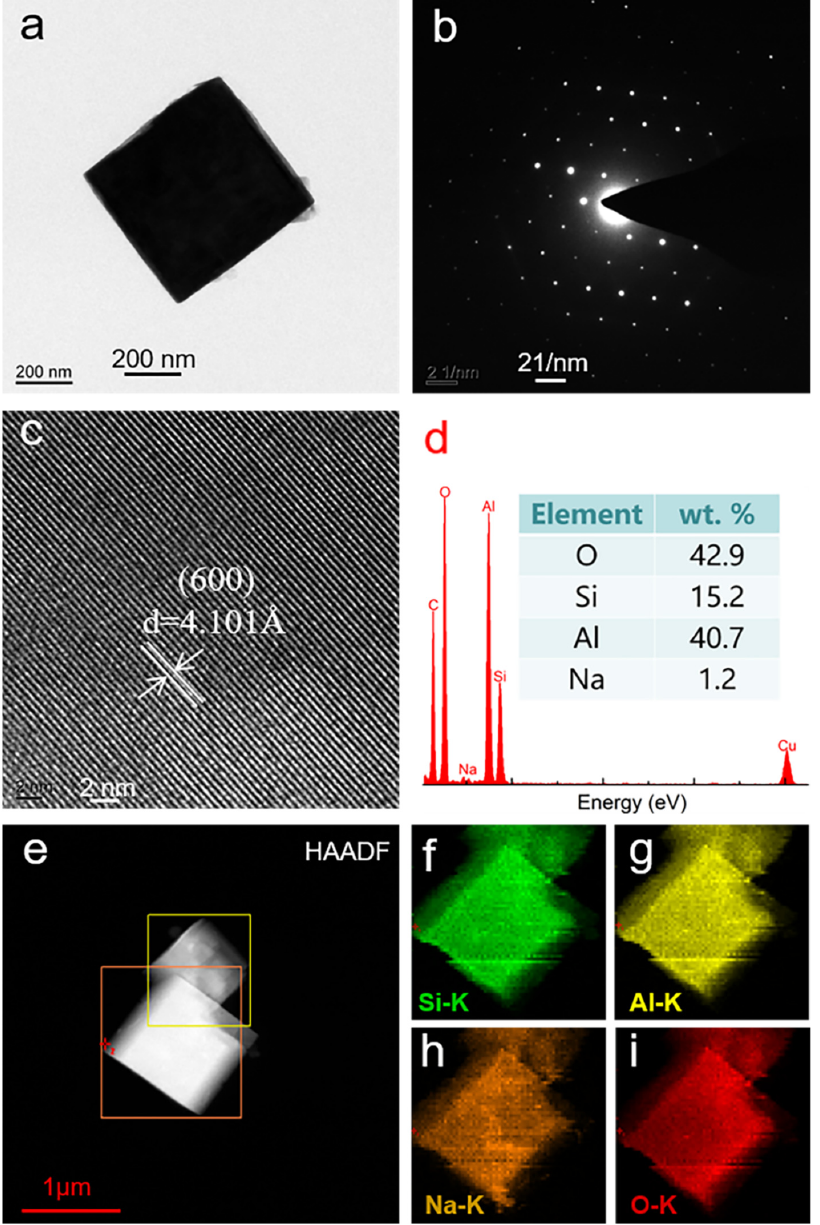
Figure 6. TEM analysis results of zeolite A. ( a ) TEM micrograph, ( b ) SAED, ( c ) lattice fringes, and ( d ) EDX pattern and element content (inset); HAADF STEM- EDX elemental spectrum of zeolite A. ( e ) selected areas, ( f ) Si element distribution, ( g ) Al element distribution, ( h ) Na element distribution, ( i ) O element distribution.